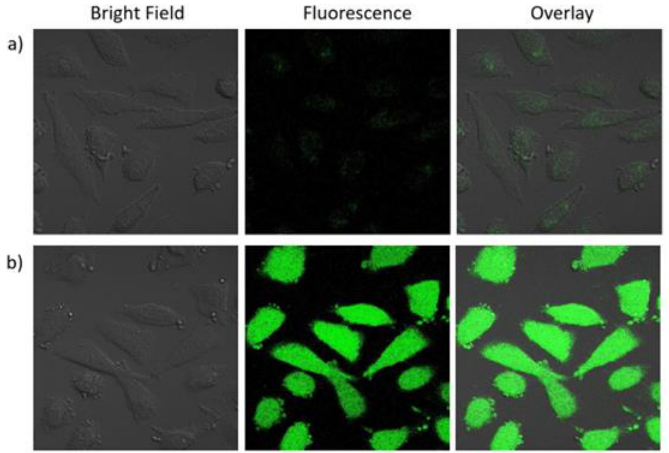
Figure 7. Viability of HeLa cells in the presence of ( a ) 3S and ( b ) 4S with and without light irradiation; ( c ) viability of HeLa cells in the presence of 4S with light irradiation under normoxia and hypoxia.